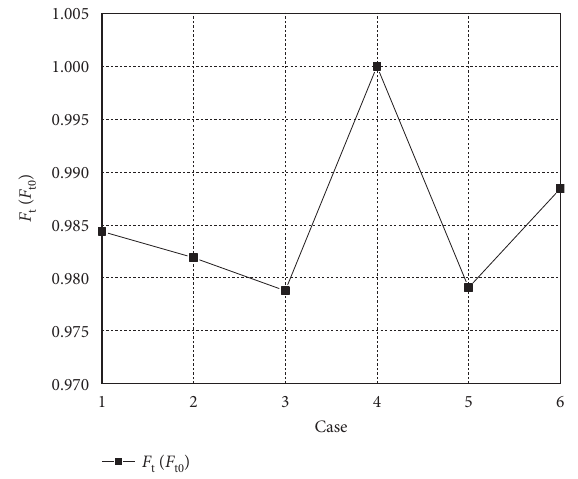
Figure 14: The thrust changes with the length of the inlet